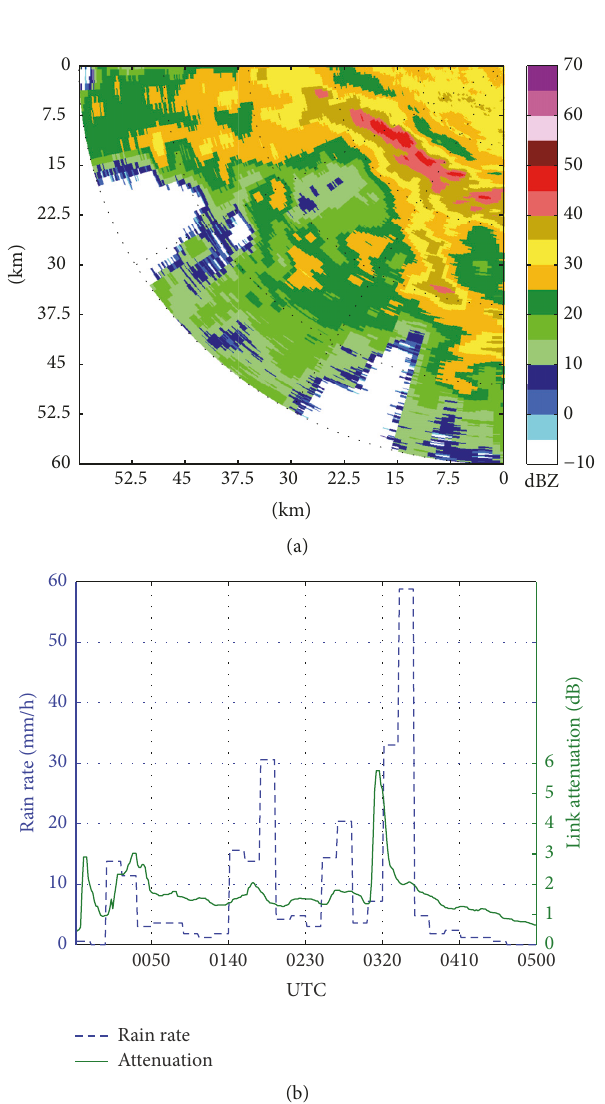
Figure 13: (a) Reflectivity PPI at elevation 1 ∘ of the X-band radar at 0330 UTC, 1 June 2016. The circles correspond to radar ranges of 12, 24, 36, 48, and 60km, respectively. (b) Rain rates derived by gauge 9 from 0000 to 0500 UTC, 1 June 2016. The attenuation recorded by ML2 is also shown in (b).